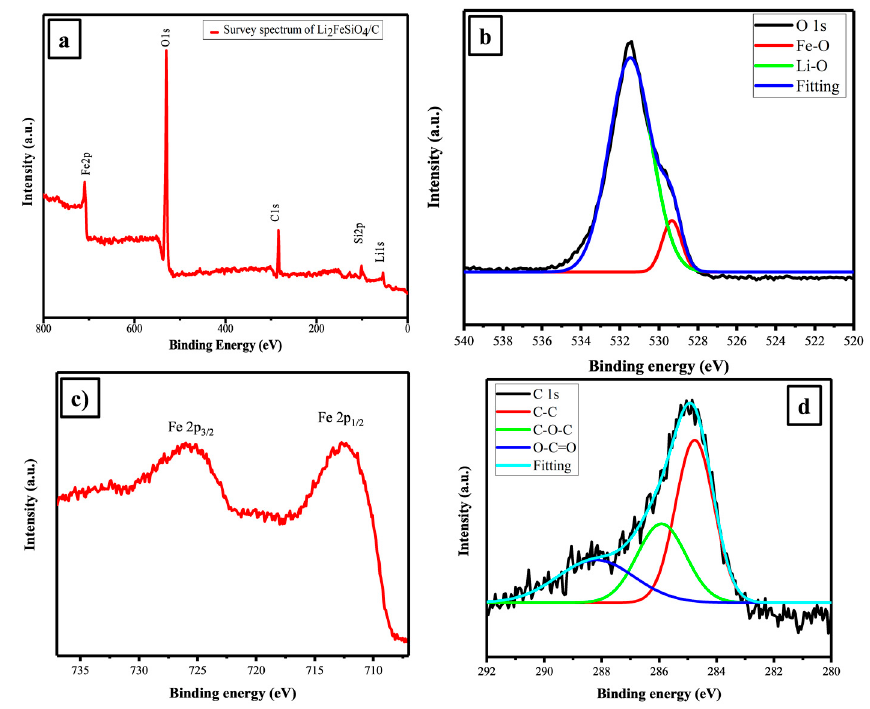
Figure 2. ( a ) Survey, ( b ) O 1s, ( c ) Fe2p and ( d ) C1s X-ray photoelectron spectroscopy (XPS) spectra of Li 2 FeSiO 4 /C.